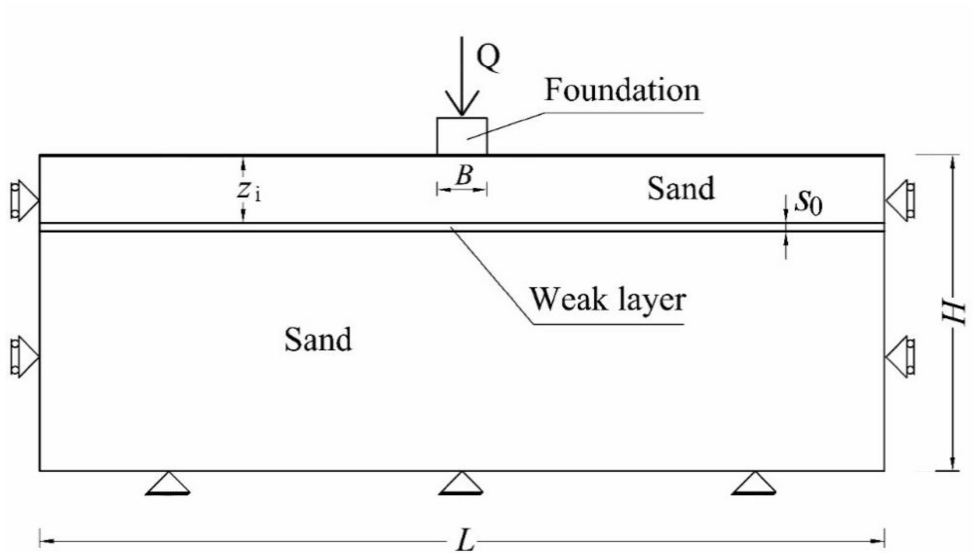
Figure 1. Scheme for the formulation of the problem: the weak layer is horizontal and is located at depth z i from the ground surface. The boundary conditions and the dimensions of the model are also presented in the